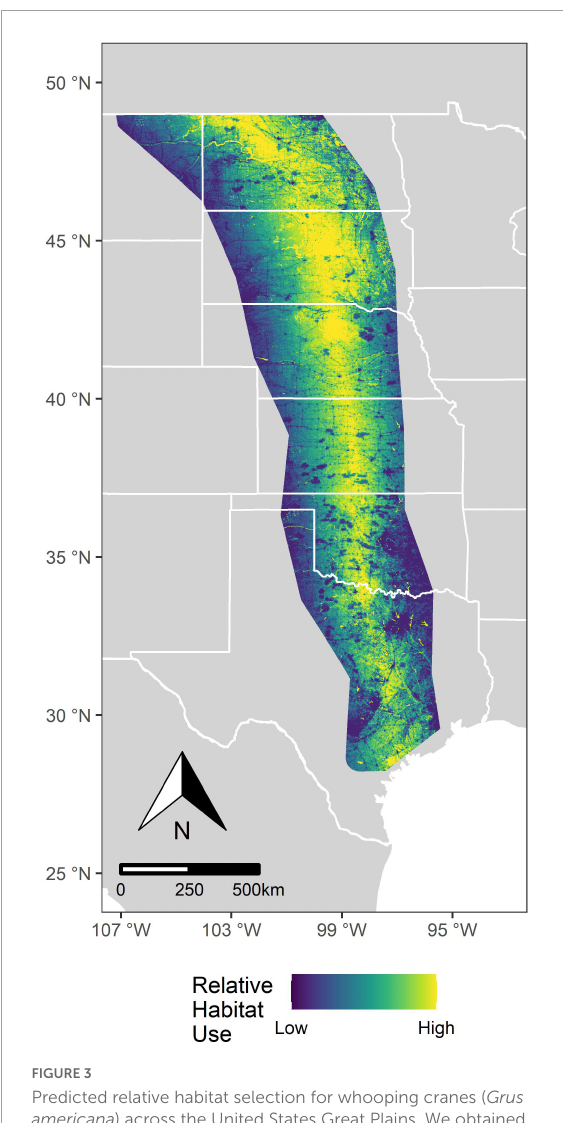
FIGURE4 Percentage of relative habitat loss for migrating whooping cranes ( Grus americana ) and the cumulative gain in wind power density (W/m 2 ) if all proposed wind towers were to be developed across the U.S. migration corridor. We optimized wind tower selection using three prioritization scenarios with different weights on habitat loss and wind